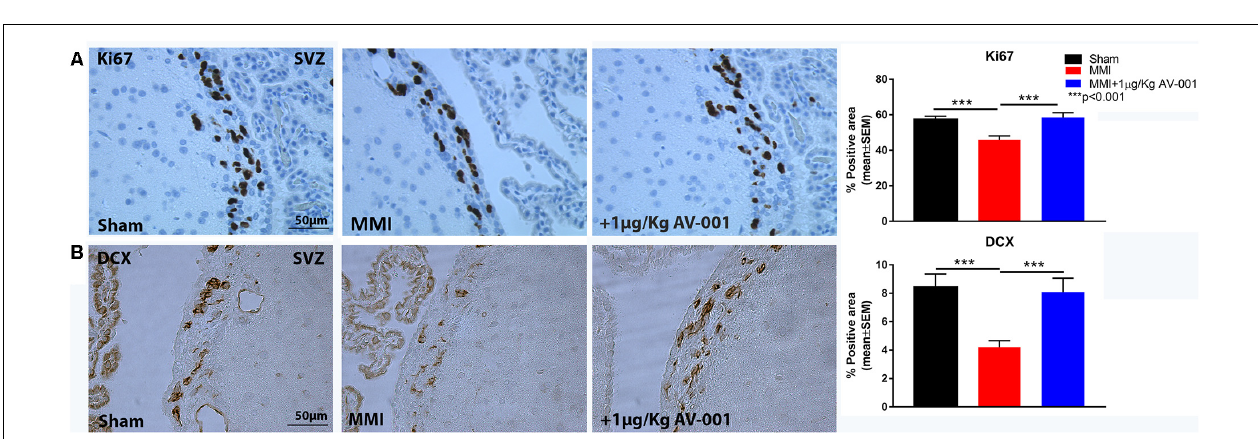
FIGURE 7 | AV-001 treatment significantly increases neurogenesis in middle-aged rats subjected to MMI. (A) Representative images and quantification data of Ki67 immunostaining in the sub ventricular zone (SVZ). MMI significantly reduces cell proliferation in the SVZ compared to Sham control rats. Treatment with 1 µ g/Kg AV-001 significantly improves cell proliferation in the SVZ compared to control MMI animals. (B) Representative images and quantification data of DCX immunostaining in the sub ventricular zone (SVZ) brain region. MMI significantly reduces neurogenesis in the SVZ compared to Sham control rats. Treatment with 1 µ g/Kg AV-001 significantly improves neurogenesis in the SVZ compared to control MMI